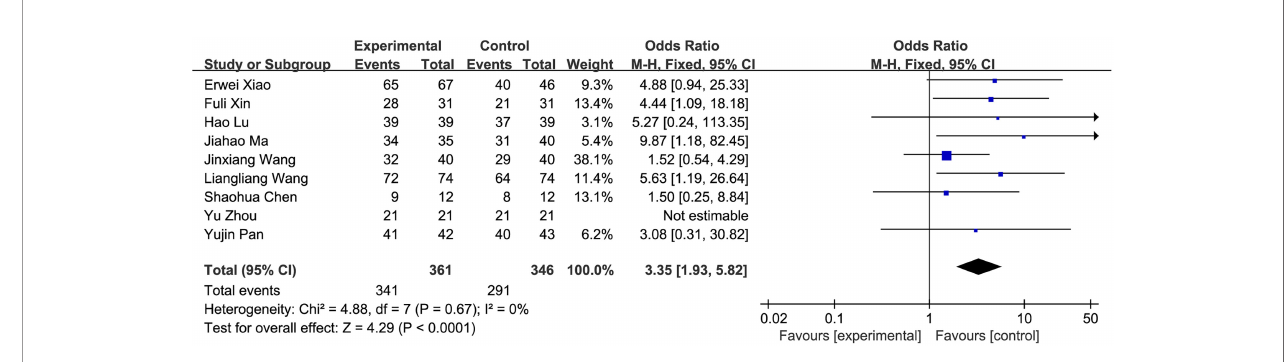
FIGURE 3 | R0 resection between groups with and without ICG fl uorescence navigation.